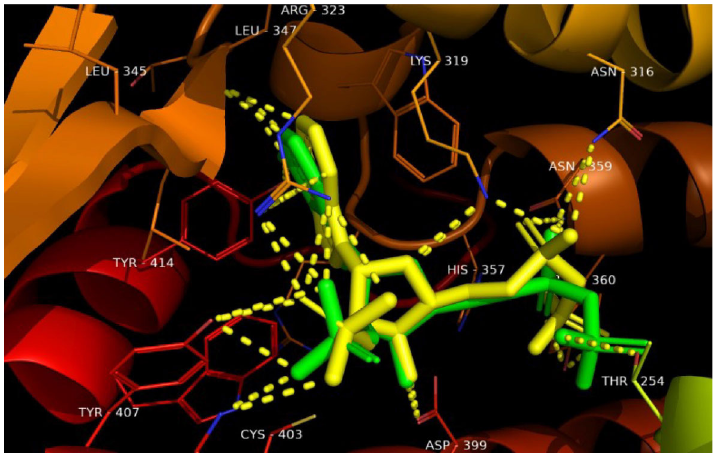
Figure 3. Overlapping NADPH ligand from D 14-sterol reductase with best conformation of redocking. Green: Protein Data Bank co-crystal. Yellow: binder conformation after redocking. Dotted yellow: hydrogen-bond